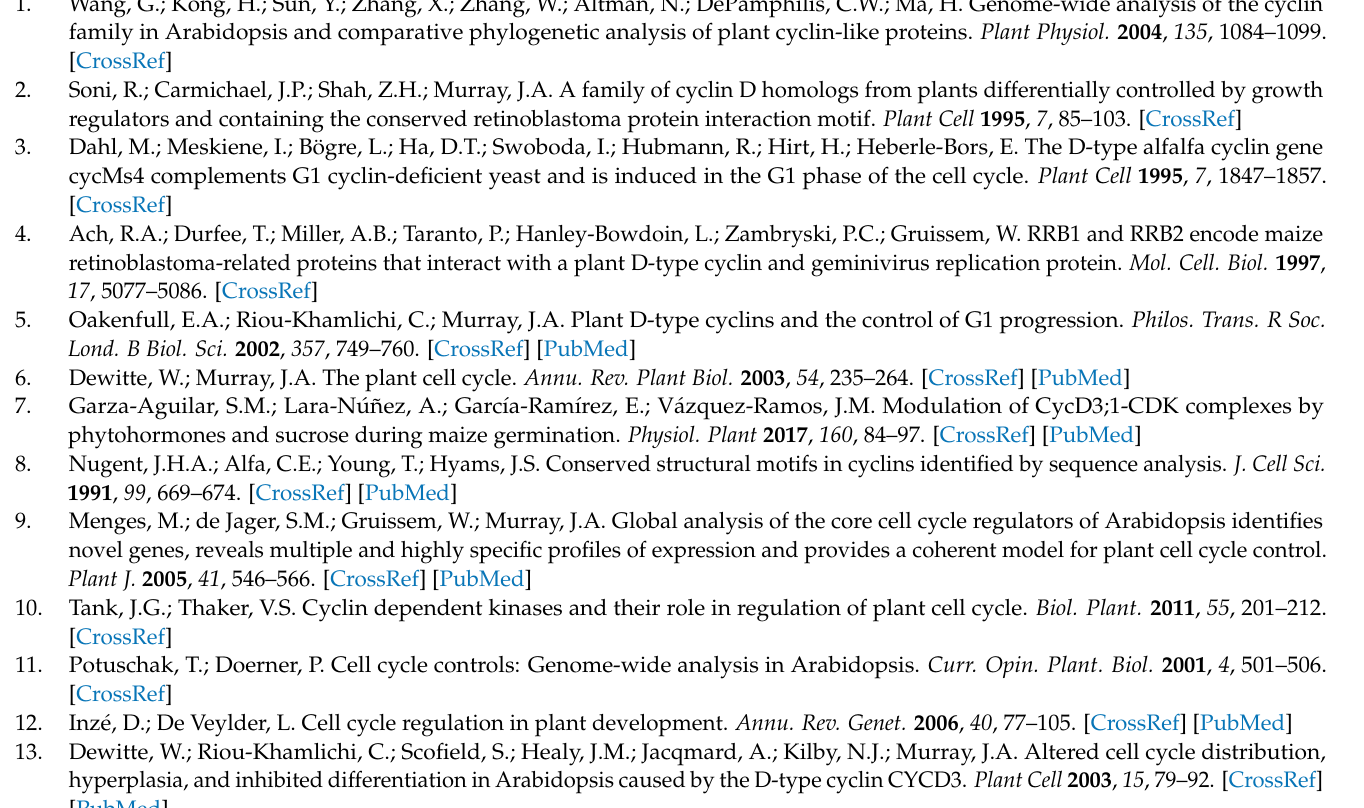
Figure S2: Expression of PtCYCD3 type genes across the wood-forming meristem sections of Populus tremula based on normalized microarray data for Schrader et al., 2004, Figure S3: Growth parame- ters of three overexpression lines, Figure S4: Phenotypes of wild-type and 35S::PtoCYCD3;3 plants, Figure S5: Cell area and cell circularity on the adaxial epidermis of wild-type and 35S::PtoCYCD3;3 leaves, Figure S6: Effect of overexpression of PtoCYCD3;3 on young stems of Populus , Figure S7: AtCYCD3 and PtoCYCD3 sequence alignment, Figure S8: Hormone content of wild-type and 35S::PtoCYCD3;3 plants, Figure S9: Phylogenetic tree of CYCD members from PtCYCD genes